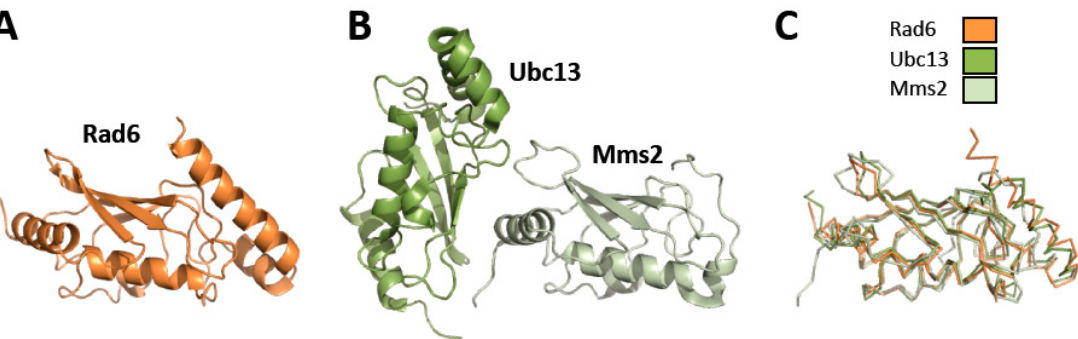
Figure 2. Structures of Rad6, Ubc13, and Mms2. ( A ) Ribbon diagram of Rad6 (orange) (1AYZ.pdb) [41]. ( B ) Ribbon diagram of Ubc13-Mms2 (dark green and light green, respectively) (1JAT.pdb) [43]. ( C ). Overlay of the structures of Rad6 (orange), Ubc13 (dark green), and Mms2 (light green).